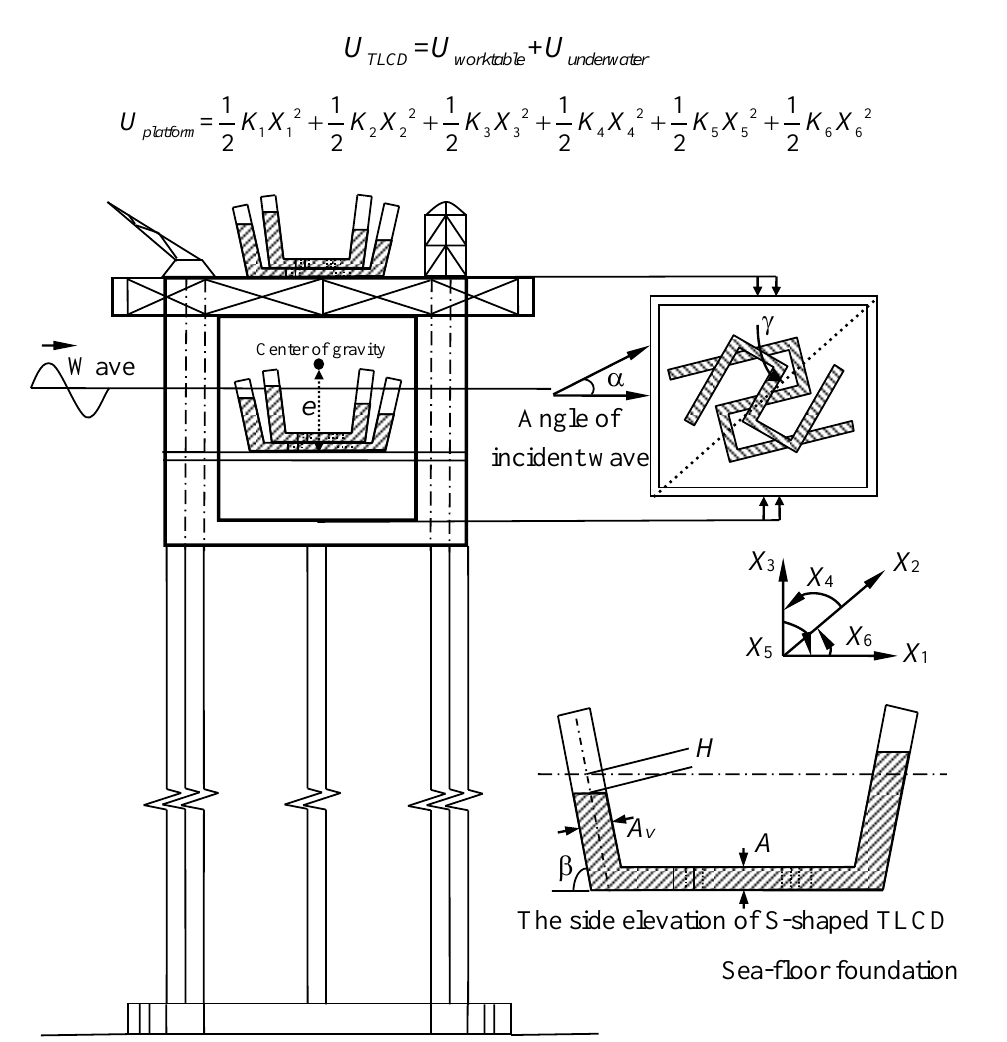
Figure 5. S-shaped TLCDs installed on a tension leg